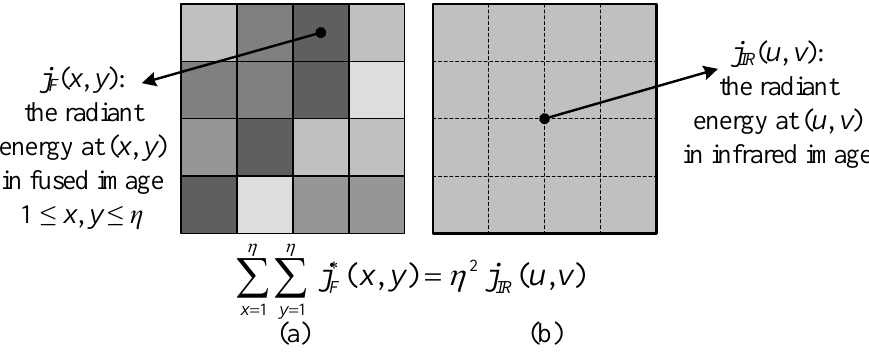
Figure 2. Illustration of physical correction. ( a ) A η × η window in the fused image. Here, η = 4. ( b ) One pixel in the low-resolution IR image. It is interpolated to the same scale as (a). Both windows in (a) and (b) should have the same amount of radiation energy.